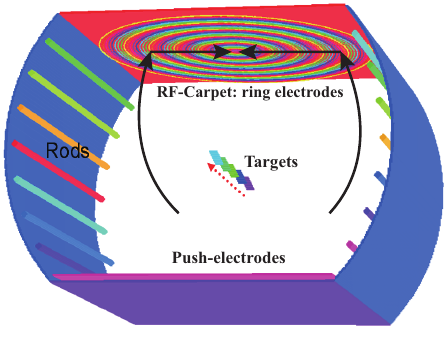
Figure 2. (Color online) Schematic drawing of the gas cell for the proposed IGISOL facility at ELI-NP. The RF carpet is composed of a stack of concentric ring electrodes. The direction of the gamma beam is indicated with the dotted arrow. Examples of trajectories of two photofission fragments in the gas cell are shown by the solid